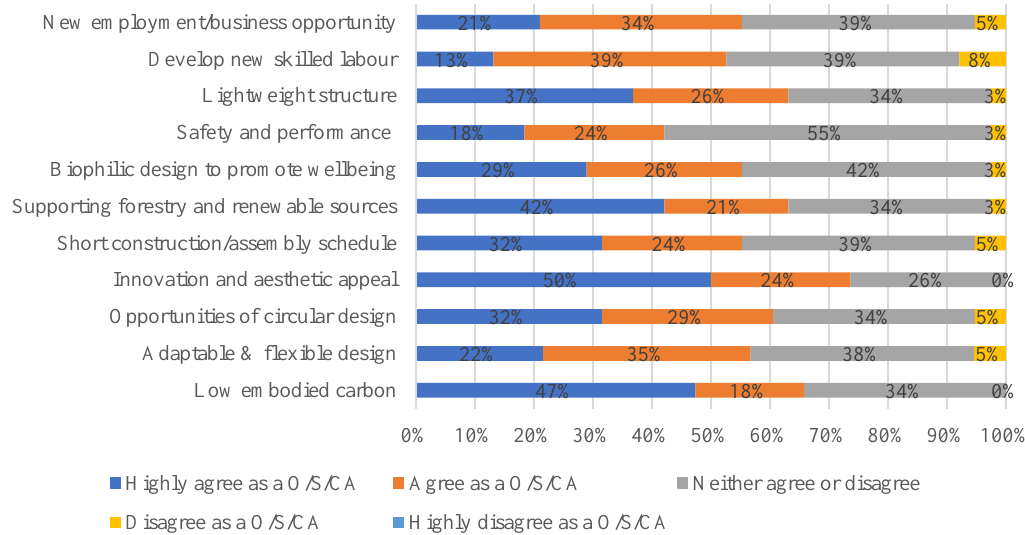
Figure 8. Opportunities, strengths, and competitive advantages of MTC in the Australian Market.